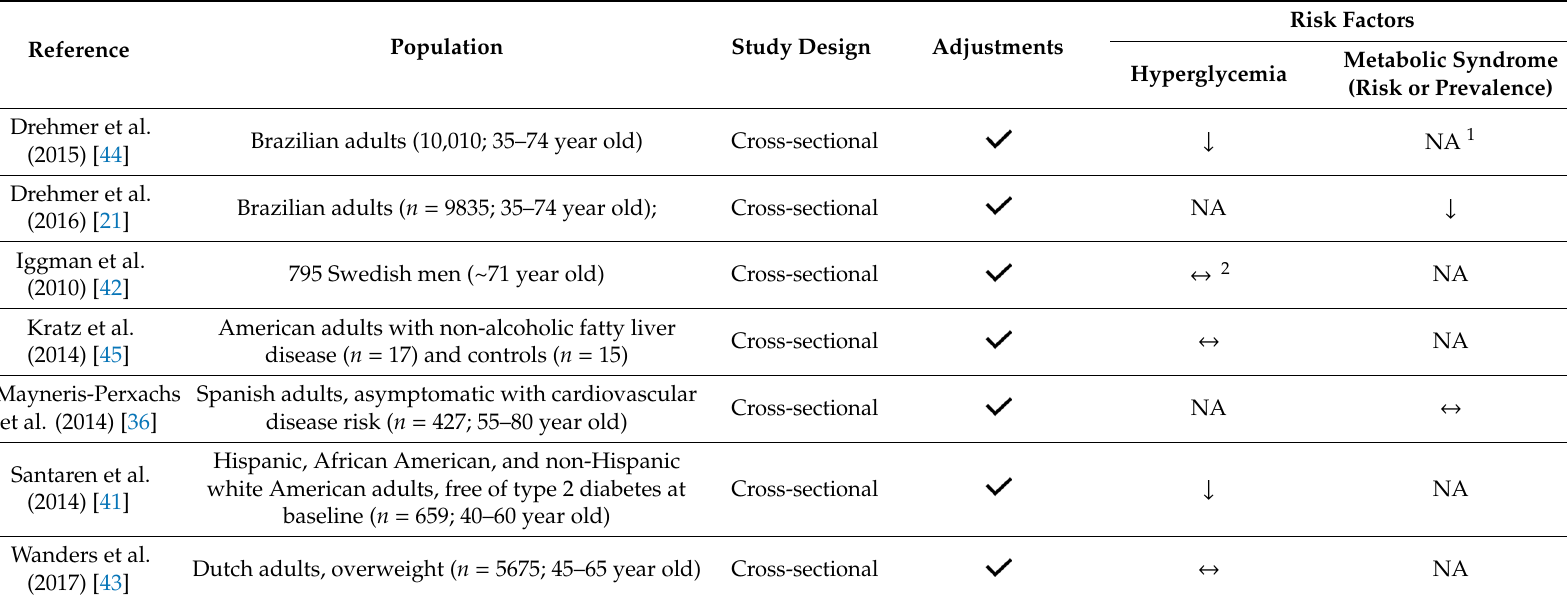
Table 3. Summary of clinical evidence on the effect of the intake of dairy-derived saturated fatty acids on metabolic syndrome risk.